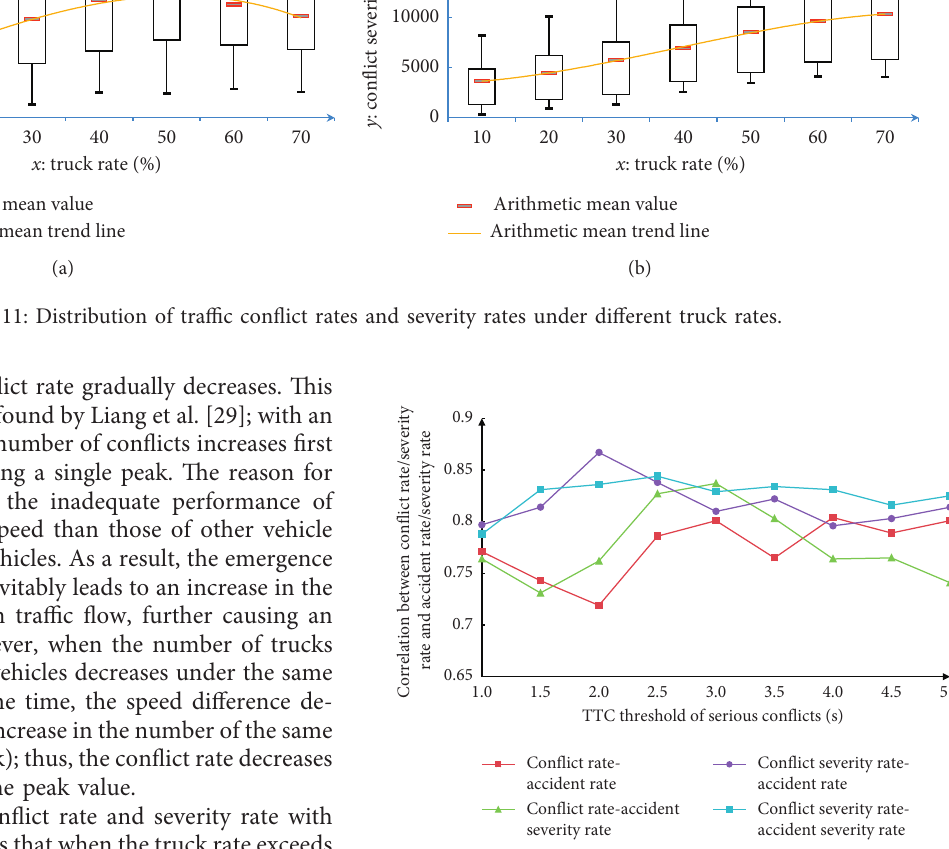
Figure 12: Correlation between conflict rate/severity rate and accident rate/severity rate under different TTC threshold